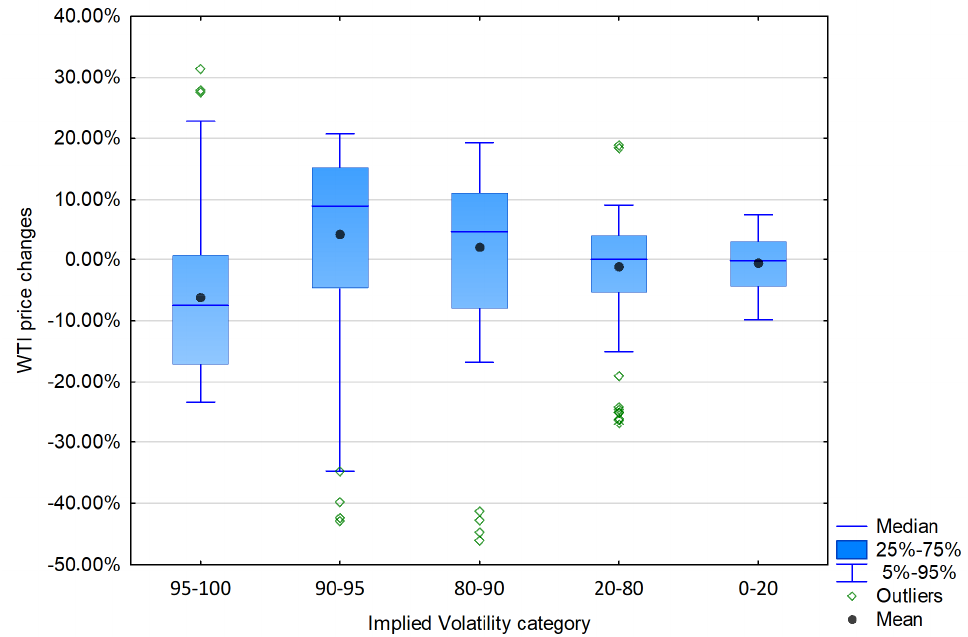
Figure 4. Box-and-whisker plot for the WTI crude oil price changes in five categories of implied volatility with the time to expiration for 11 to 34 days.